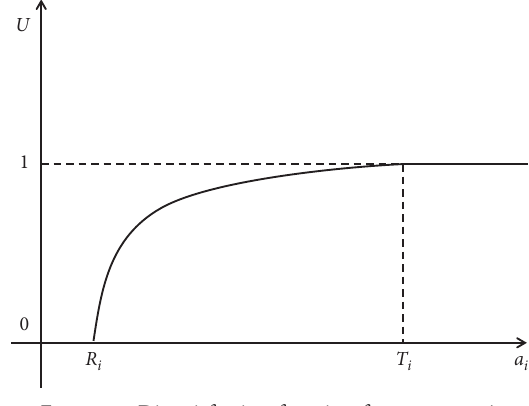
Figure 1: Time window description.